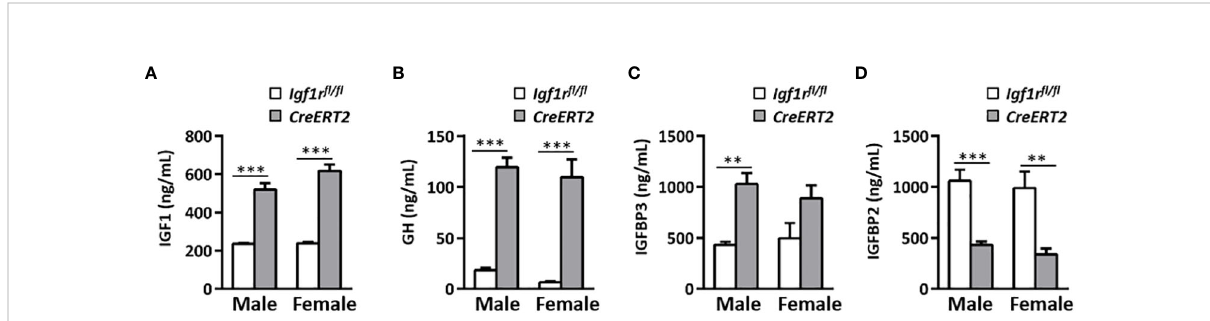
FIGURE 3 Effects of IGF1R de fi ciency on IGF1, GH, IGFBP3, and IGFBP2 circulating levels in young mice. Quanti fi cation of IGF1 (A) GH (B) IGFBP3 (C) and IGFBP2 levels (D) in serum of 13 weeks-old Igf1r fl / fl and CreERT2 males and females. Data are expressed as mean ± SEM of at least 5 animals per group (n= 5-14 mice per group). **p < 0.01, ***p < 0.001 vs . Igf1r fl / fl corresponding